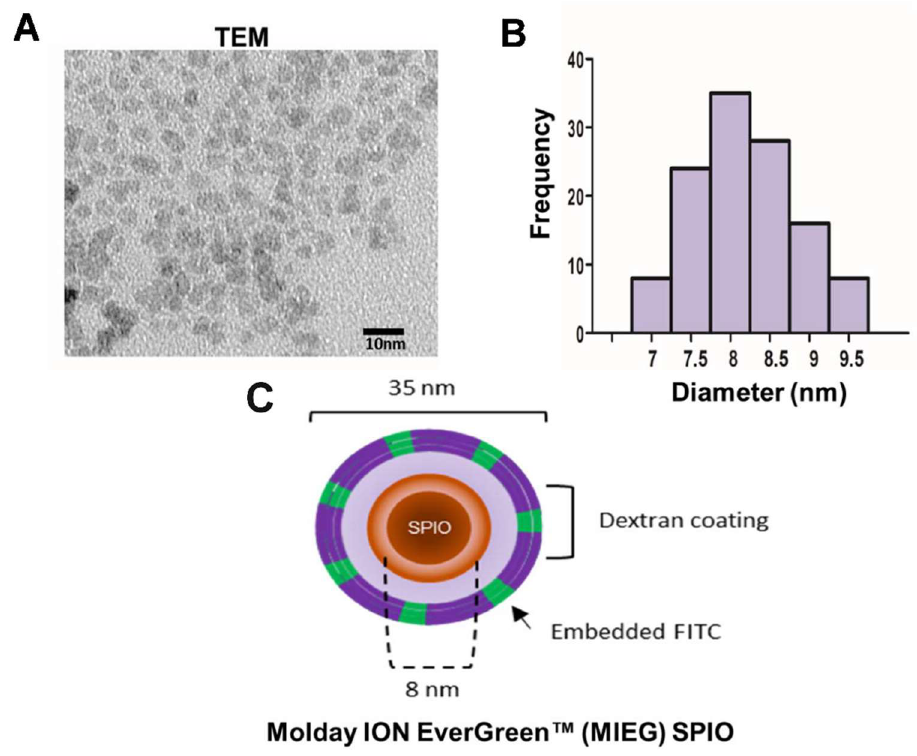
Figure 2. Characterization of MoldayION ™ EverGreen (MIEG). ( A ) Transmission electron microscopy (TEM) of MIEG at concentration of 200 µ g / mL, ( B ) size distribution of MIEG, and ( C ) a schematic illustration of MIEG. Scale bar 10 nm.